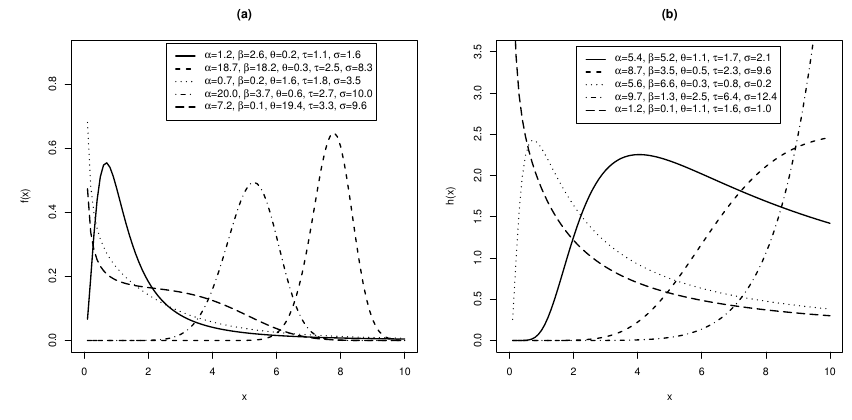
Figure 4 – Plot of the density and hazard functions of EOLxPL for some possible parameter